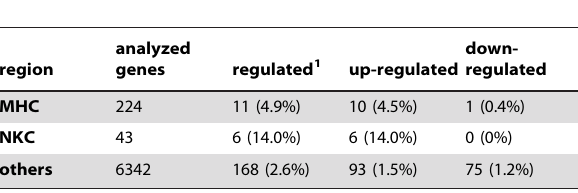
Table 2. Proportion of regulated genes as indicated by the gene expression profiling